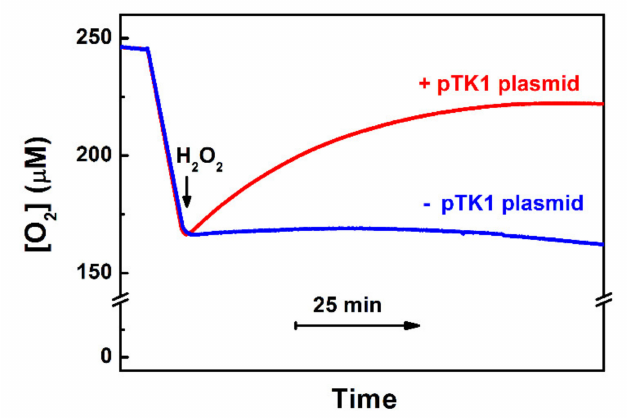
Figure 3. Catalase-like activity of catalase-deficient E. coli UM2 cells overexpressing cytochrome bd -I. Shown is the change in O 2 concentration after the addition of 0.235 mM H 2 O 2 to respiring cells in which the enzyme is either overexpressed (+pTK1 plasmid that carries the cydAB operon) or not ( − pTK1 plasmid). Adapted from